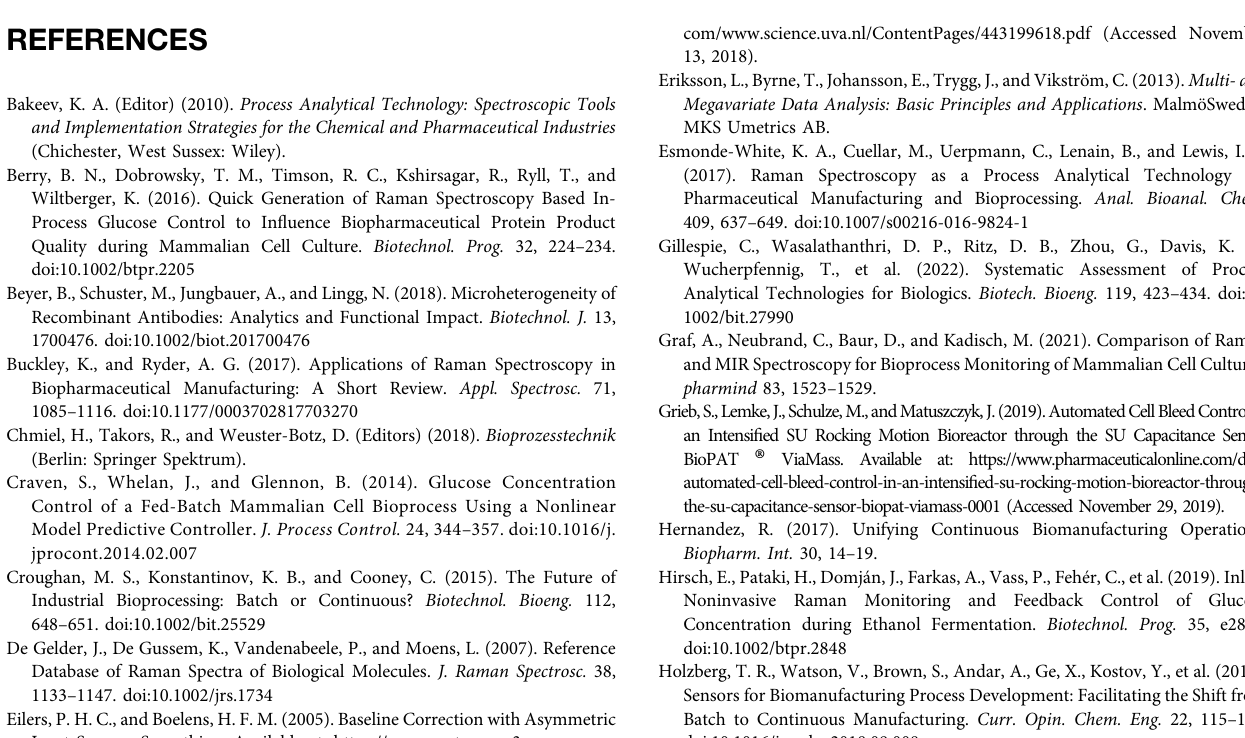
Supplementary Figure 1 | Flow chart of OPLS model building from off-line reference and in-line Raman spectral data of perfusion cultivations C1-C5. Data sets were merged by capture time and baseline corrected prior to analyte-speci fi c data